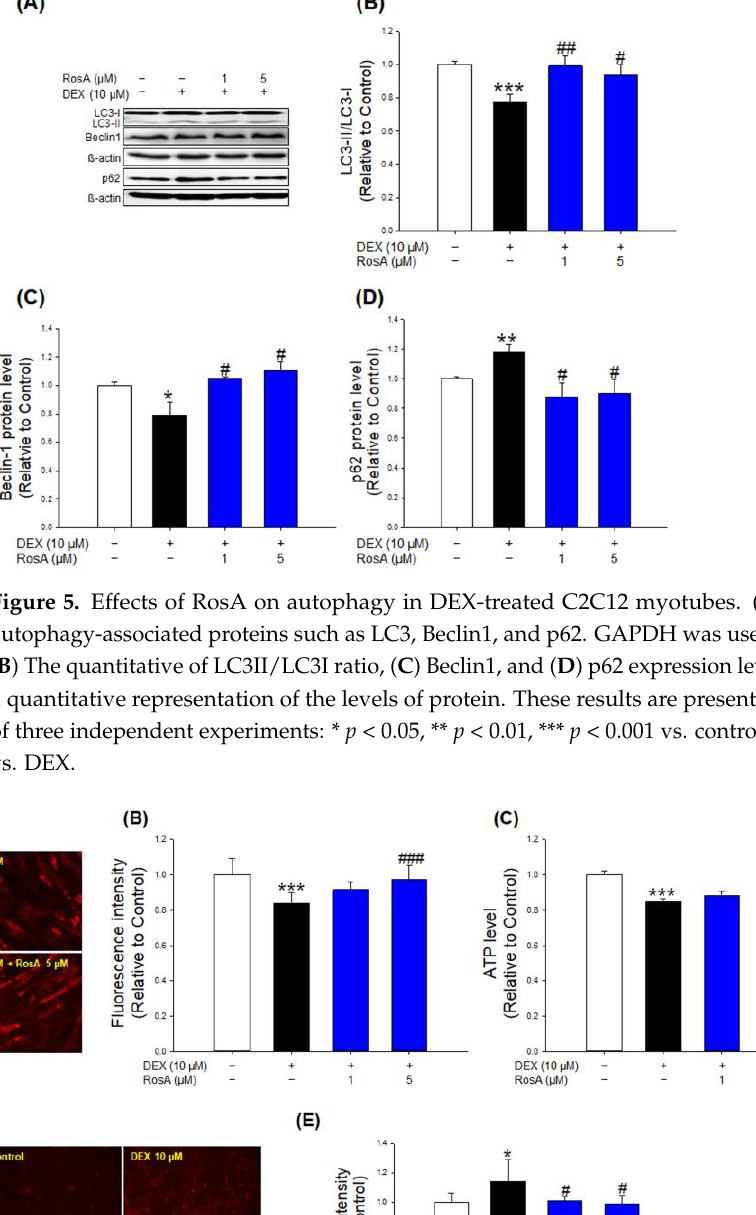
Figure 5. Effects of RosA on autophagy in DEX-treated C2C12 myotubes. ( A ) The expression of autophagy-associated proteins such as LC3, Beclin1, and p62. GAPDH was used as a loading con- trol. ( B ) The quantitative of LC3II/LC3I ratio, ( C ) Beclin1, and ( D ) p62 expression levels. The graph shows a quantitative representation of the levels of protein. These results are presented as the means ± SD of three independent experiments: * p < 0.05, ** p < 0.01, *** p < 0.001 vs. control; # p < 0.05, ## p < 0.01 vs. DEX.